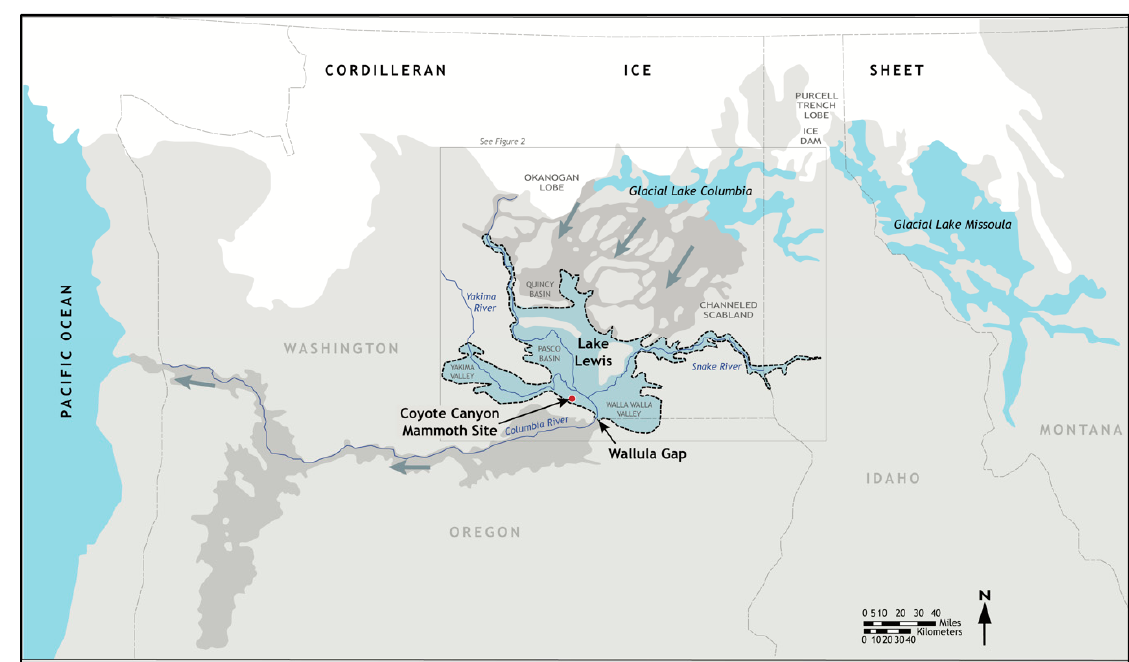
Figure 1. Schematic of the hypothetical extent of hydraulically ponded floodwaters, assuming a static flood stage of 366 m asl, forming a large transient body of water, referred to as Lake Lewis in Southeastern Washington State (based on a map available from the Ice Age Floods Institute (https://iafi.org/product/ice-age-floods-in-the-pacific-northwest-map/) accessed on 4 April 2021). Darker shading indicates areas impacted by Late Pleistocene outburst megafloods.